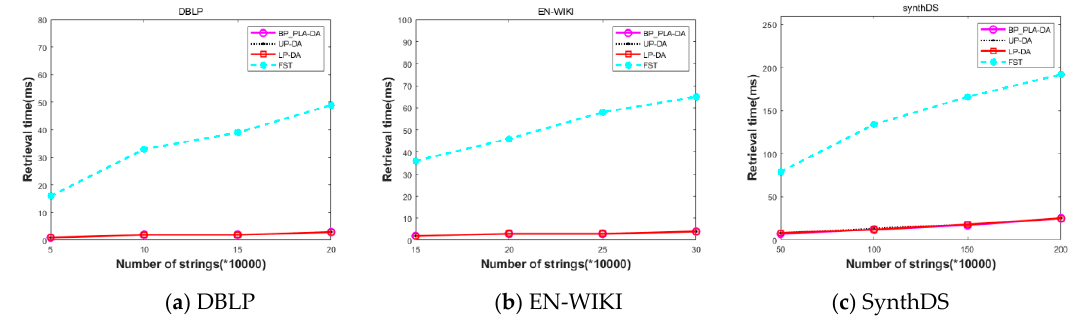
Figure 14. Parallel retrieval times for different number of strings.